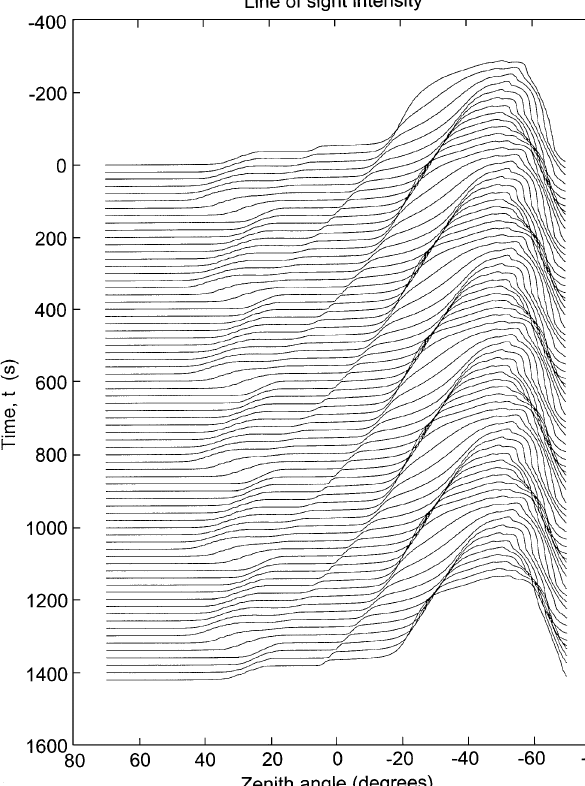
Fig. 5. Stack plot showing 630-nm luminousity observed by the meridian scanning photometer scans depicted in Fig. 4, as a function of zenith angle (positive values being northward); successive scans are shown with time running down the